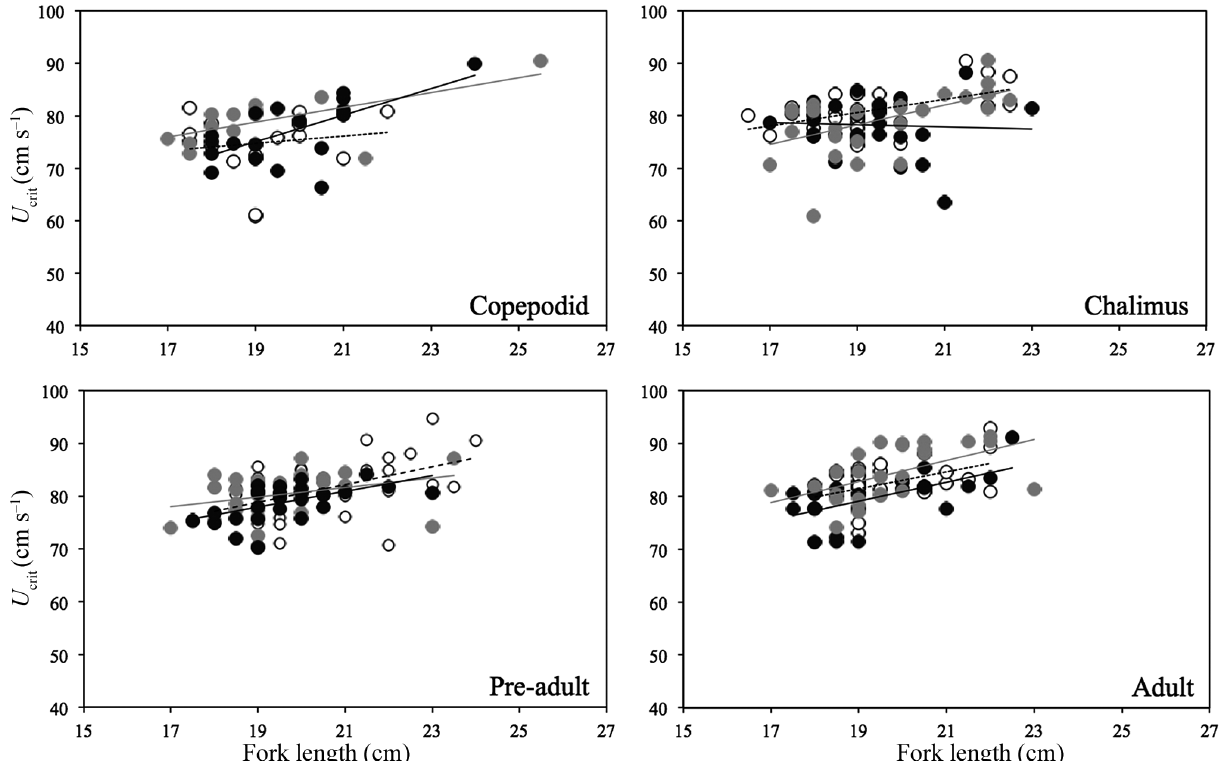
Fig. 1. Relationship between fish length and critical swimming speed ( U crit ) of host Atlantic salmon Salmo salar as tested in the swim flume, at the 4 sea lice ( Lepeophtheirus salmonis ) life-history stages examined. Increasing infestation densities are cate - gorically represented with no lice (grey circles, grey line), mid-range (30 copepodids fish −1 ; open circles, dotted line), and high-range infestation density (90 copepodids fish −1 ; black circles, black